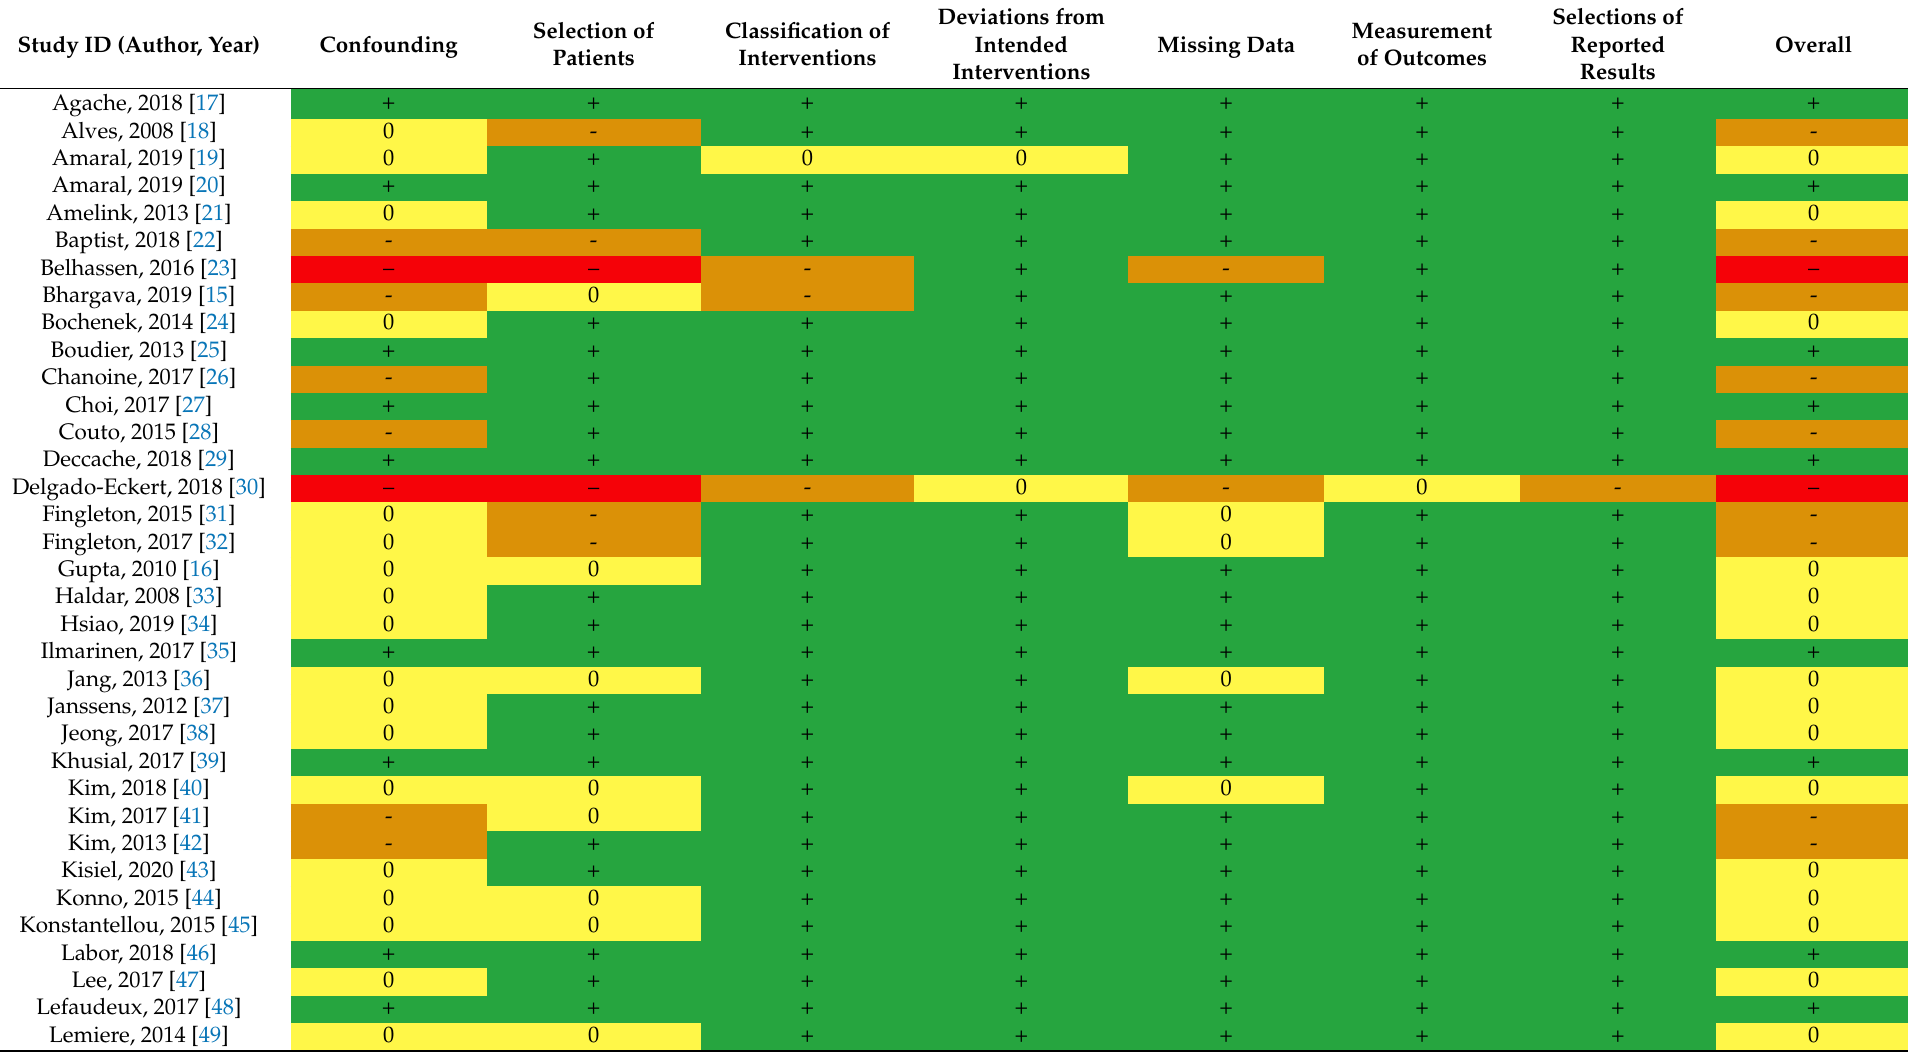
Table 5. Risk of bias assessment using